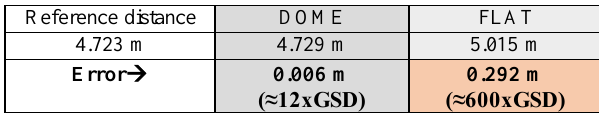
Table 2. Summary of the length